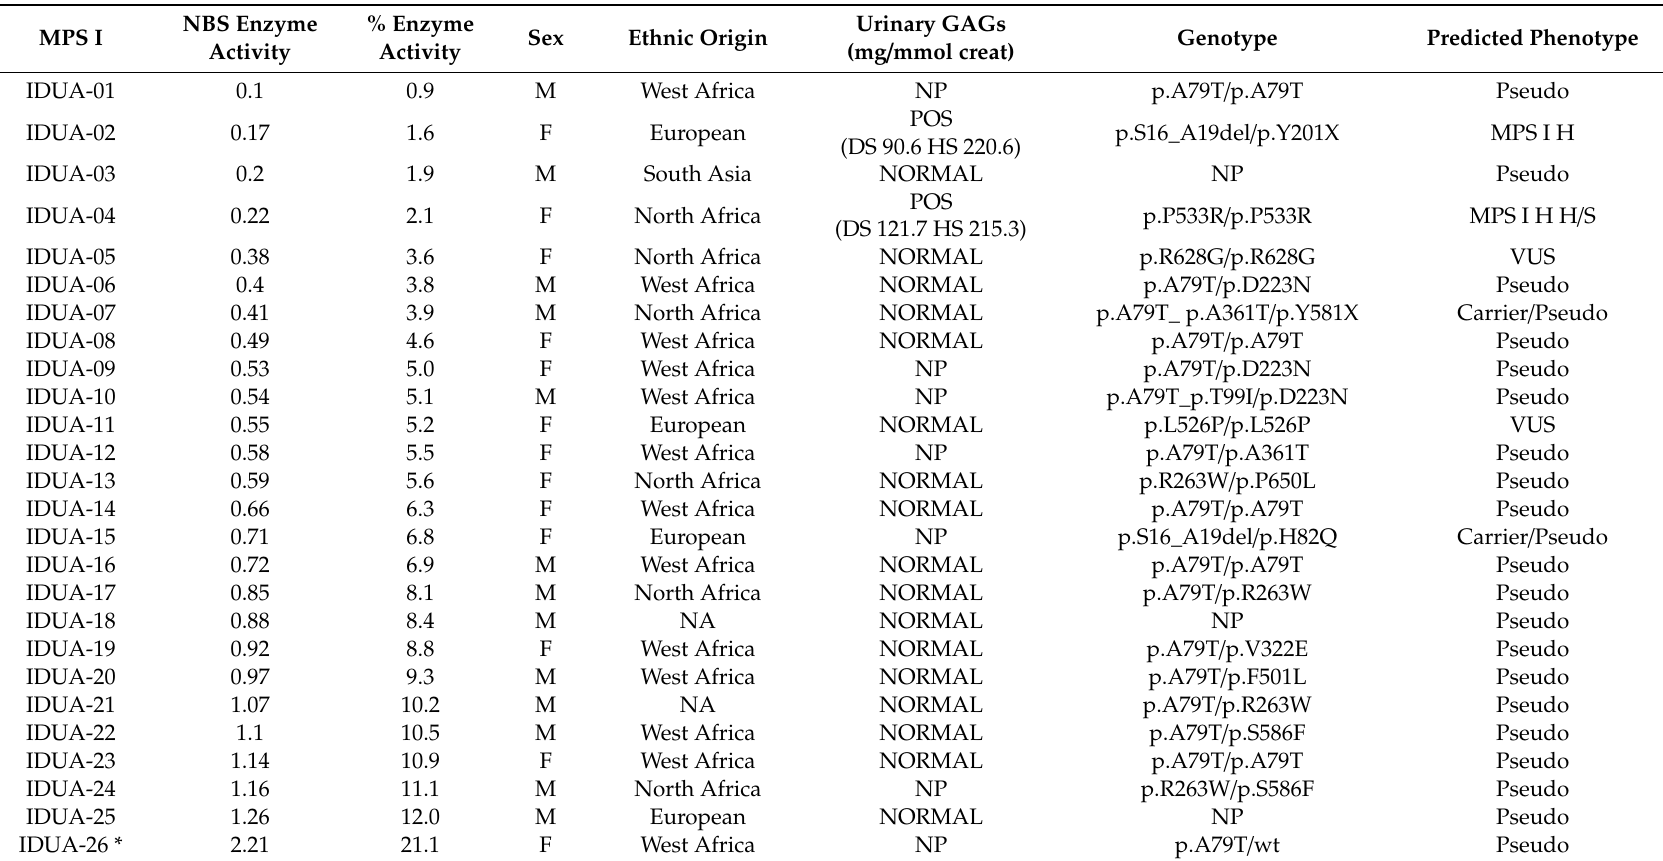
Table 3. NBS enzyme activity, confirmatory testing results and final diagnosis in newborns with suspicion of MPS I. Newborns were ordered based on neonatal screening enzyme